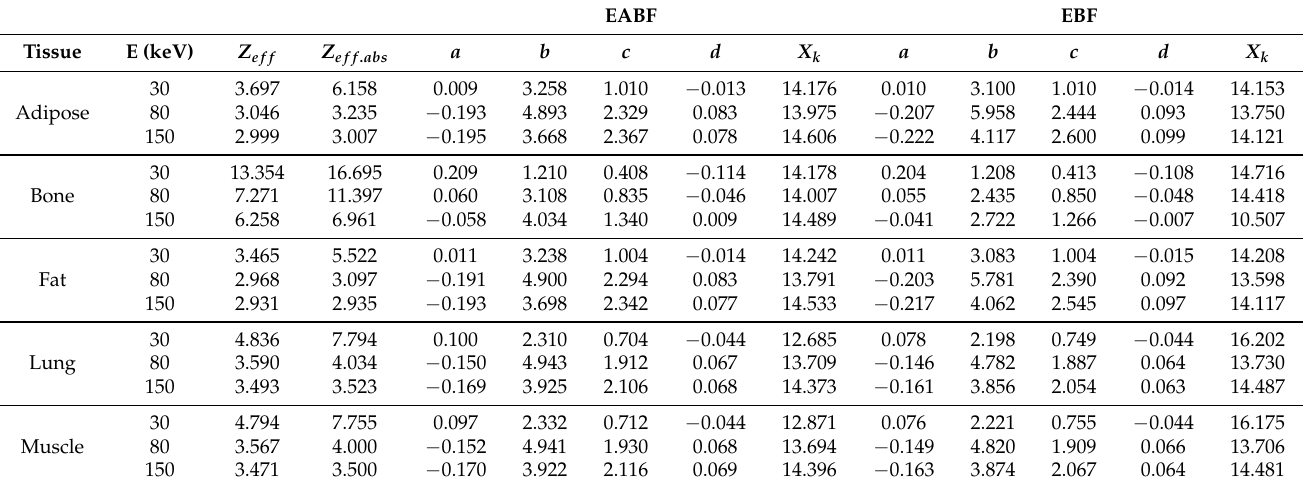
Table 3. Tissue radiological parameters (GP-fitting BUF coefficients and effective and absorption effective atomic numbers) for photon energy of 30, 80, and 150